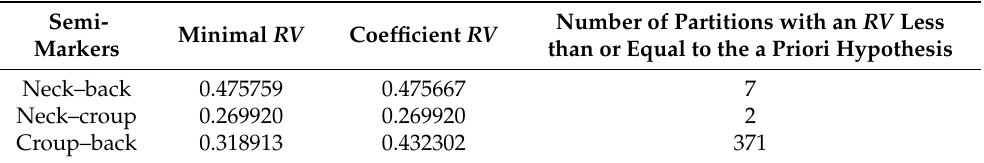
Table 2. Partial least-squares (PLS) values (% total variation) for the different studied profile units. Table 1. Results of the modularity analysis by the Escoufier RV coefficient (10,000 rounds of ran- domization) for the different profile units studied.